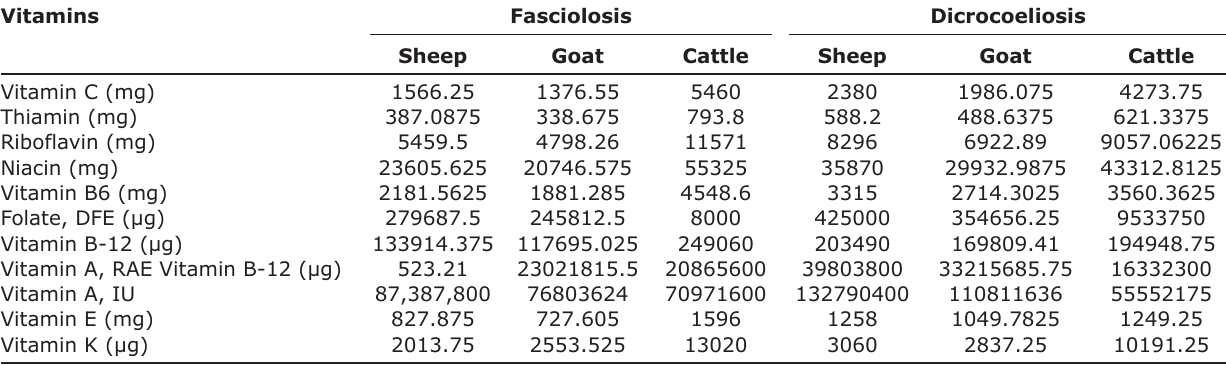
Table-5: The level of Group B vitamin elimination in livers infected with Fasciola hepatica, Fasciola gigantica , and Dicrocoelium dendriticum at Arak abattoirs. Vitamins Goat Cattle Sheep Goat